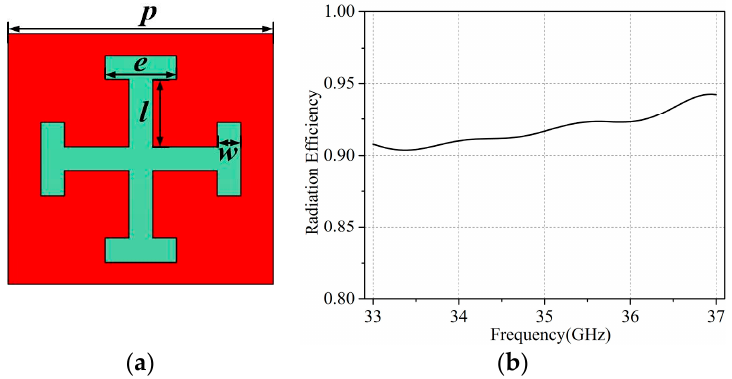
Figure 5. ( a ) Top view of complementary Jerusalem cross (CJC) element with a unit cell size of 2 mm and ( b ) a radiation efficiency of the element.